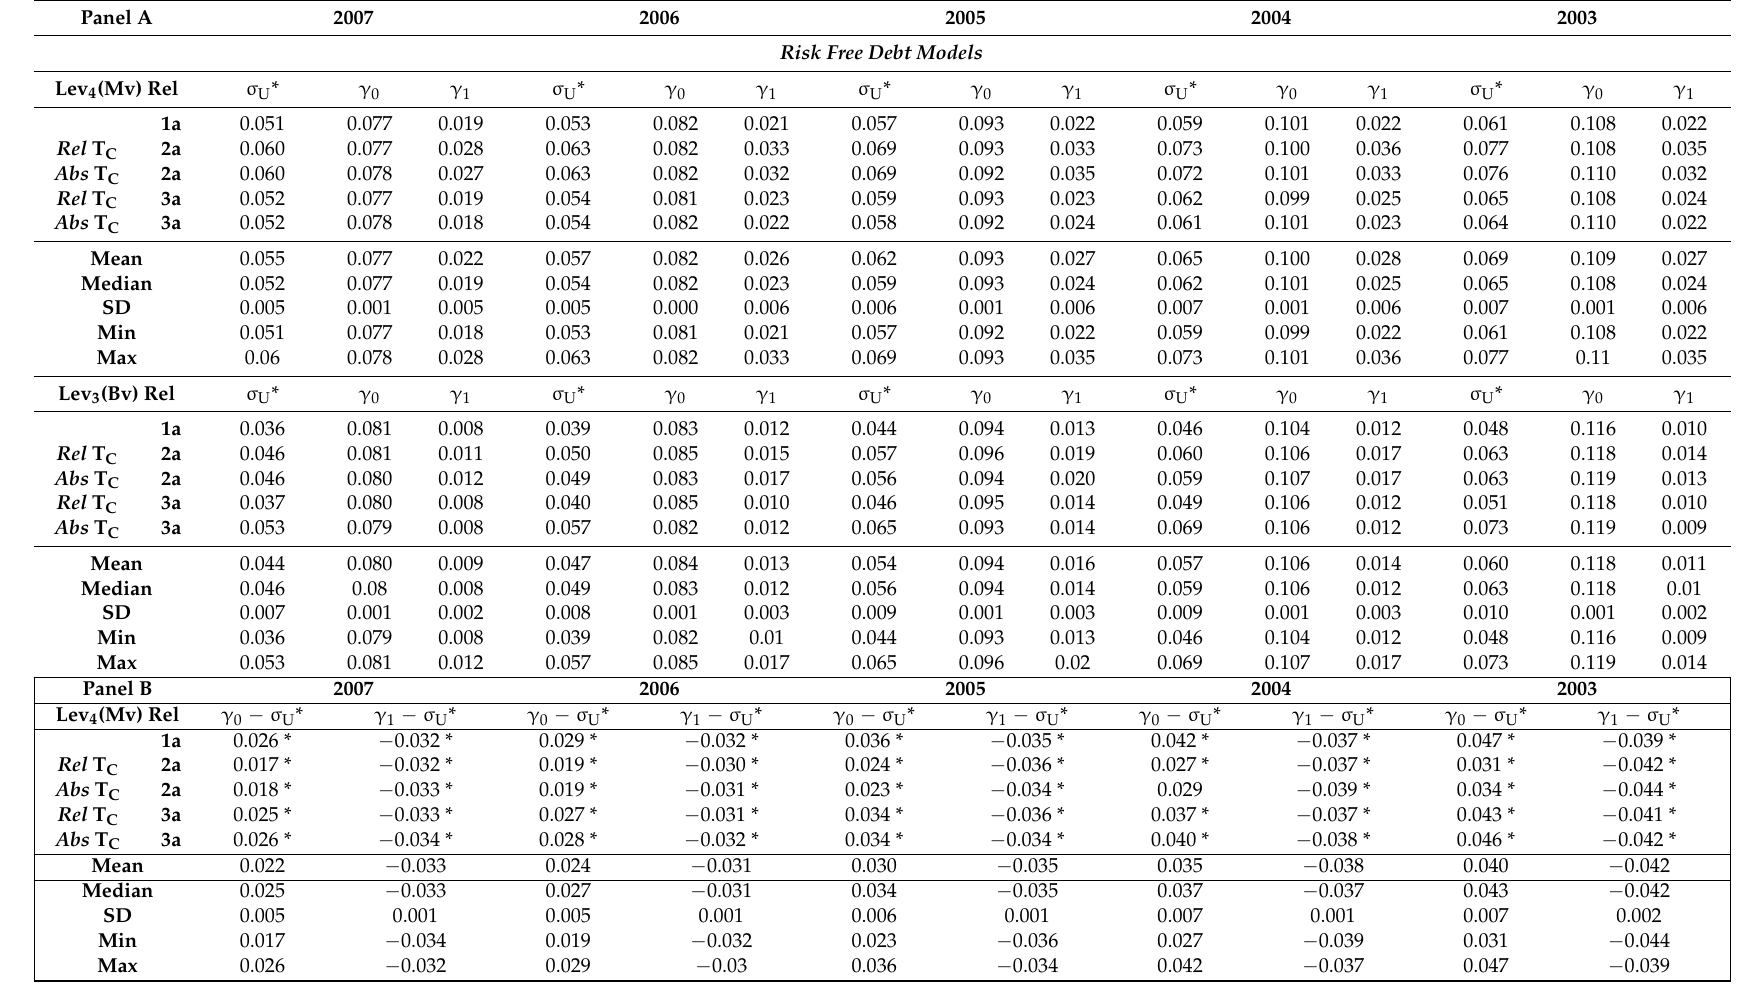
Table 3. Comparison results by method